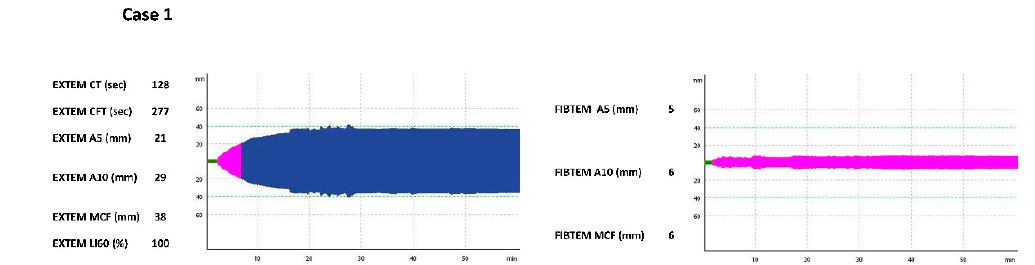
Figure 1. Hemostatic profile of the patient at the day of clinical deterioration, as depicted by ROTEM EXTEM and FIBTEM graphic representation and numerical results. Abbreviations: CT, clotting time (min, green colour); CFT, clot formation time (min, pink colour); A5 and A10, clot amplitude at 5 and 10 min (mm); MCF: maximum clot firmness (mm, blue colour); LI60, lysis index at 60 min (%).